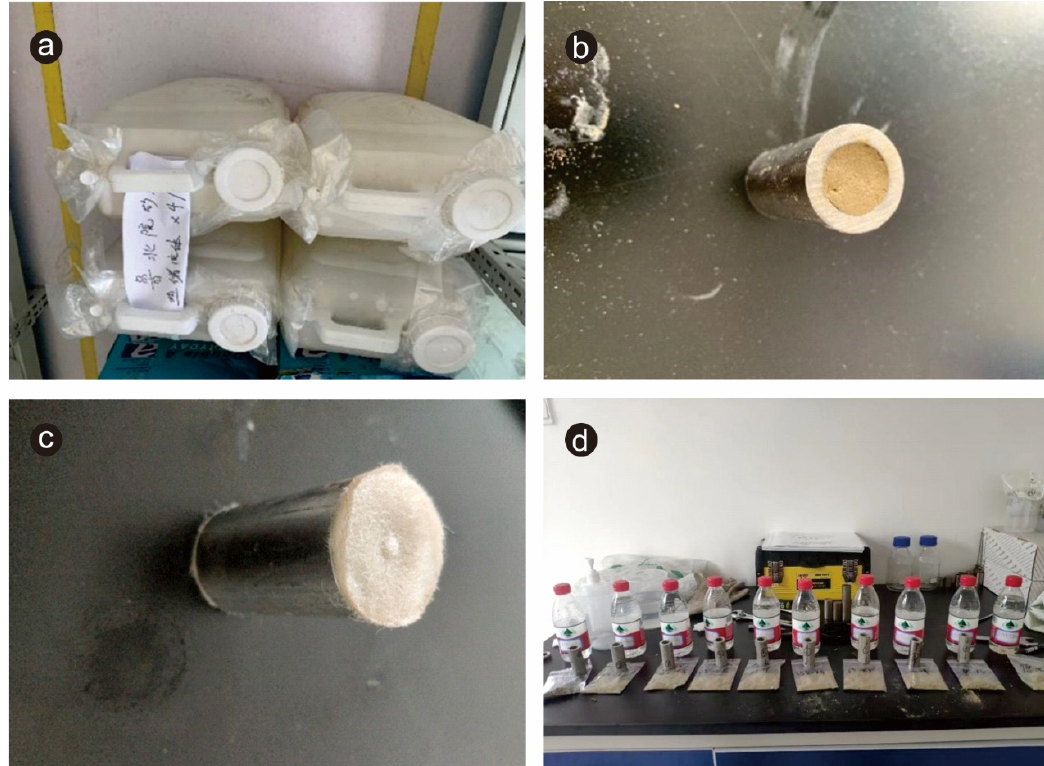
Figure 1. Preparation of water and rock samples. ( a ) Geothermal fluid collected from the sandstone geothermal reservoir; ( b ) Ground sandstone specimens filling stainless ‐ steel pipes; ( c ) Stainless ‐ steel pipe ends are blocked with filtered cotton; ( d ) Sandstone samples and fluid samples after the experiment for major elements and mineral analysis.